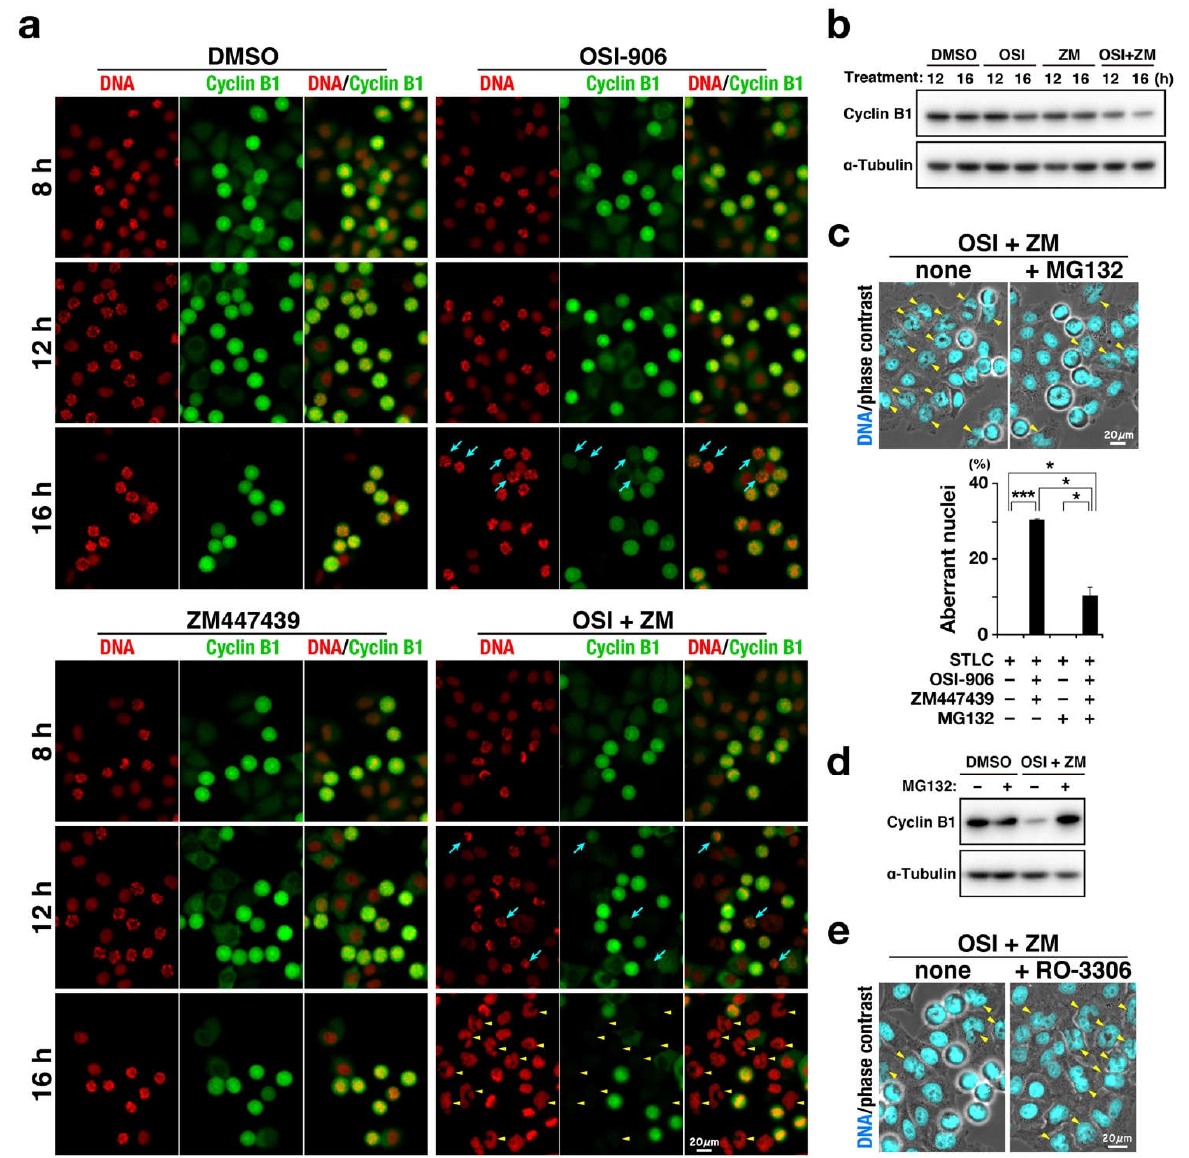
Figure 5. Combination of OSI-906 and ZM447439 causes mitotic slippage via precocious degradation of cyclin B1. HeLa S3 cells were treated with 7.5 µM S-trityl-L-cysteine in the presence of OSI-906, ZM447439, or their combination (OSI + ZM). Dimethyl sulfoxide was used as solvent control (DMSO). ( a ) At 8, 12, and 16 h after the start of treatment, cells were fixed and stained for cyclin B1 (green) and DNA (red). Representative images are shown. Blue arrows indicate M phase cells with lower expression levels of cyclin B1. Yellow arrowheads indicate cells with aberrant nuclear morphologies. Scale bar, 20 µm. ( b ) At 10 h after the treatment, M phase cells were collected by mitotic shake-off and further incubated in microtubes at 37 °C for 2 h and 6 h. Whole cell lysates were analyzed using Western blot with the indicated antibodies. The full blots are shown in Figure S1. ( c ) At 12 h after the treatment, 40 µM MG-132 was added to the culture. The cells were further incubated for 4 h and stained for DNA (cyan). Yellow arrowheads indicate cells with aberrant nuclear morphologies. Scale bar, 20 µm. The number of cells with aberrant-shaped nuclei was counted and plotted as the mean ± SD calculated from three independent experiments (n > 112). p -values were calculated using the Games – Howell multiple comparison test. * p < 0.05; *** p < 0.001. ( d ) At 10 h after the treatment, M phase cells were collected by mitotic shake-off and further incubated in microtubes at 37 °C for 6 h. During the last 4 h of incubation in microtubes, the cells were treated with 40 µM MG-132. Whole cell lysates were analyzed using Western blot with the indicated antibodies. The full blots are shown in Figure S1. ( e ) At 10 h after the treatment, 6 µM RO-3306 was added to the culture. The cells were further incubated for 2 h and stained for DNA (cyan). Yellow arrowheads indicate cells with aberrant nuclear morphologies. Scale bar, 20 µm.